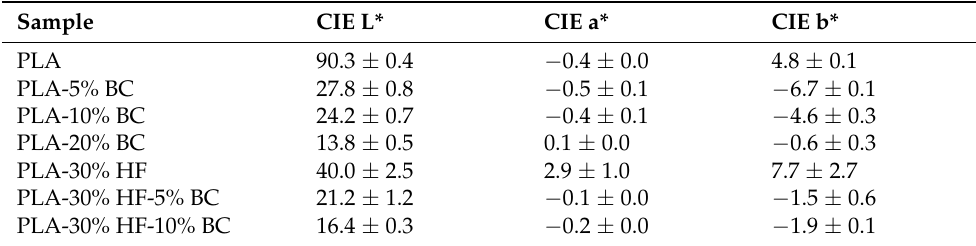
Table 3. Surface color analysis results of PLA-based composites according to the CIELAB color system (CIE L*, CIE a* and CIE b*